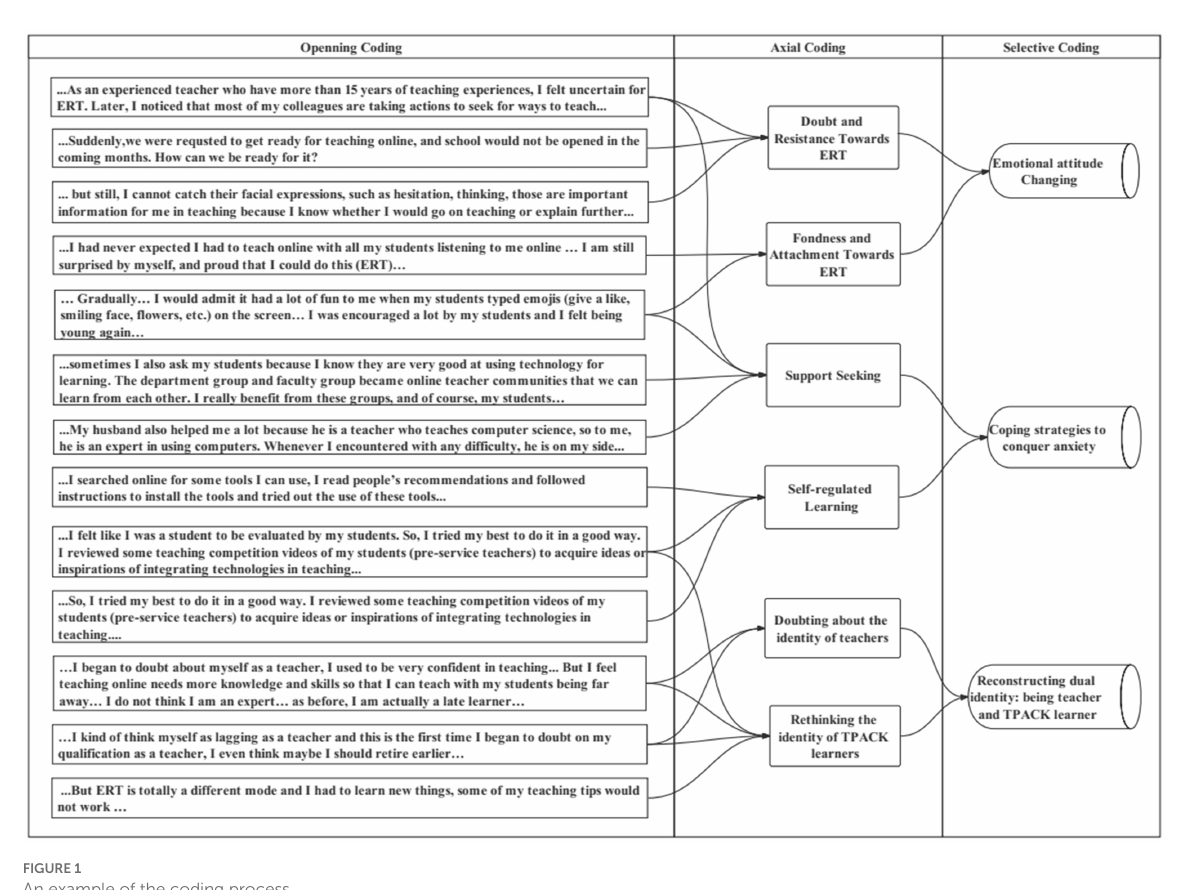
FIGURE 1 An example of the coding